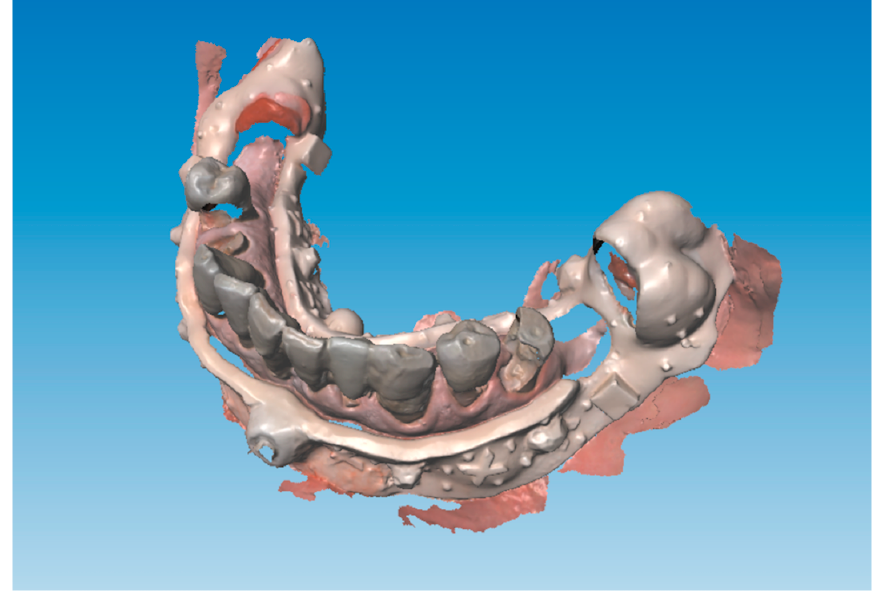
Figure 5. The lower preoperative impression taken immediately before surgery with the resin